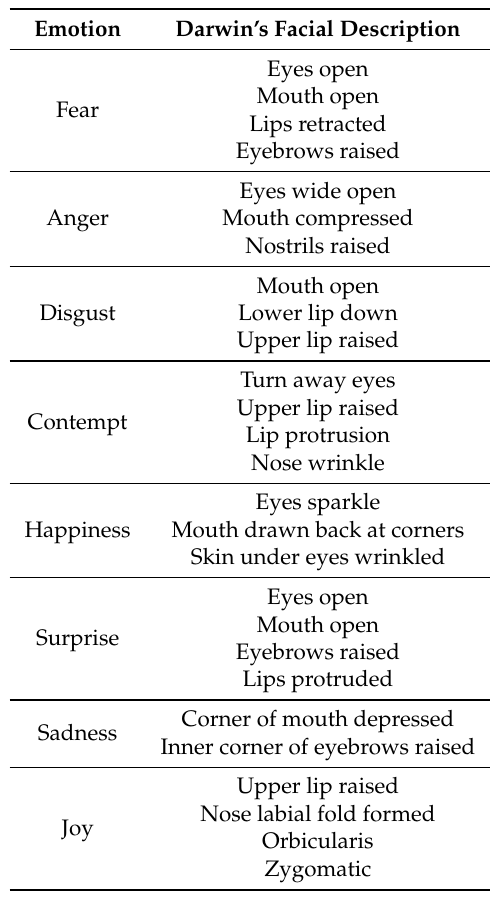
Table 1. Descriptions of facial muscles involved in the emotions Darwin considered universal